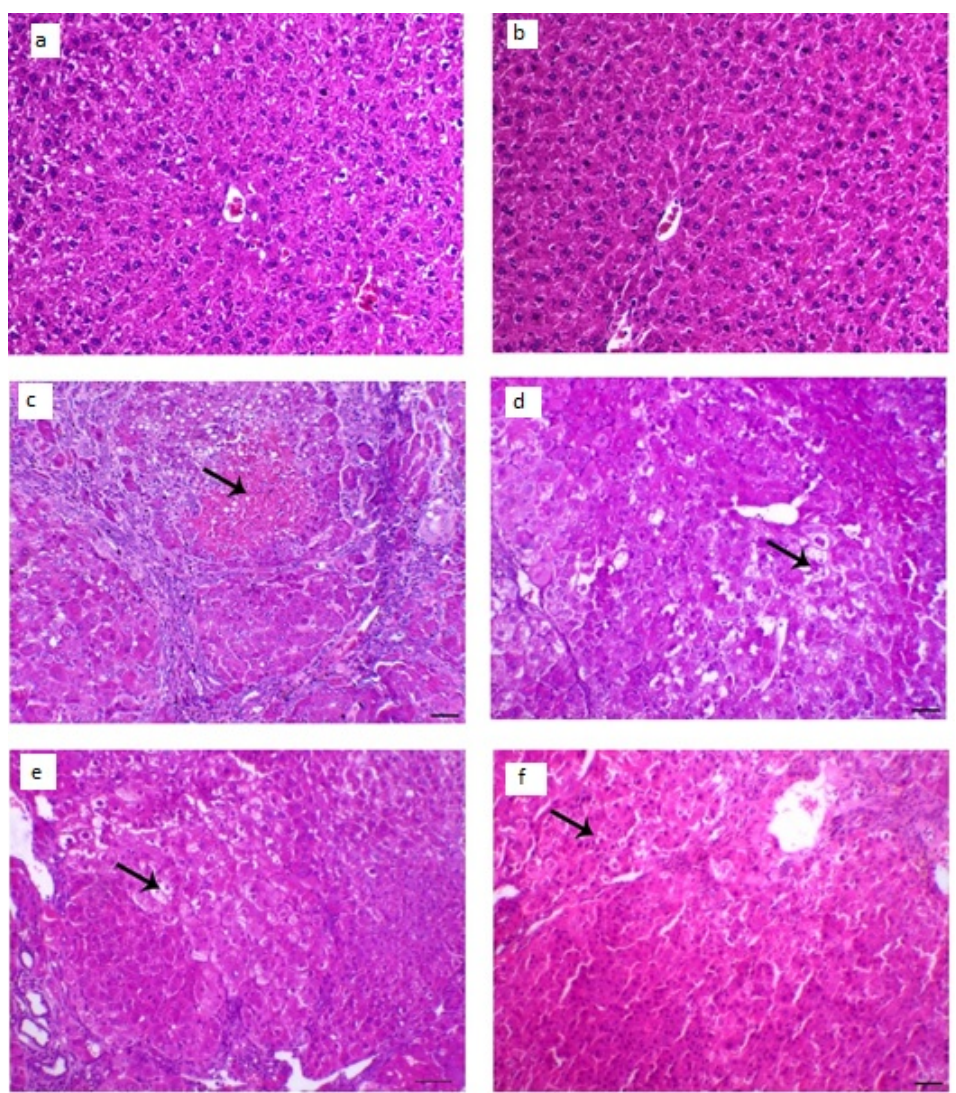
Figure 10. Histopathological changes in liver tissues; ( a , b ) liver of control animal appearing typical hepatocytes organized in lines around the central vein (arrow; H&E staining; scale bar, 100 µm, ( c , d ) liver section of the diseased animal showing HCC nodule revealing marked hepatic necrosis (arrow), H&E, bar = 100 µm., ( e ) liver segment of infected animal treated with LUT-suspension showing hepatic adenoma with hepatic vacuolar degenerative changes (arrow), H&E, bar = 100 µm, ( f ) liver segment of infected animal treated with LUT-ENPs appearing hepatic foci with marked diminish the hepatic neoplastic injuries with a little number of hepatic adenomas (arrow shows central degenerative zone), H&E, bar = 100 µm.